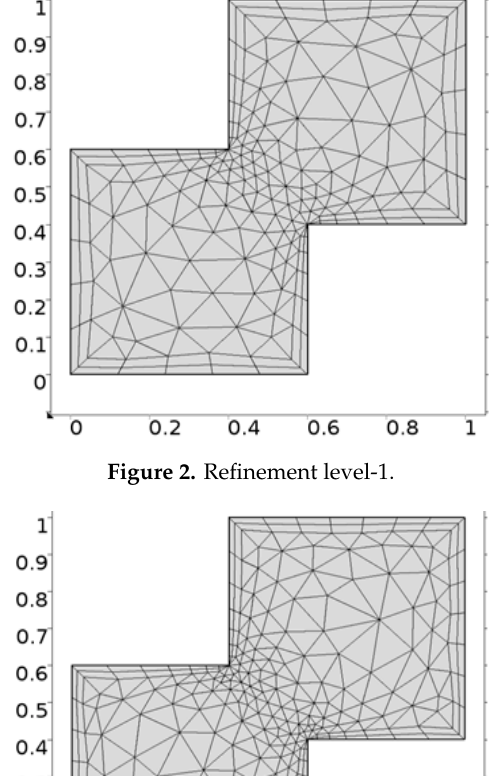
Figure 3. Refinement level-2.